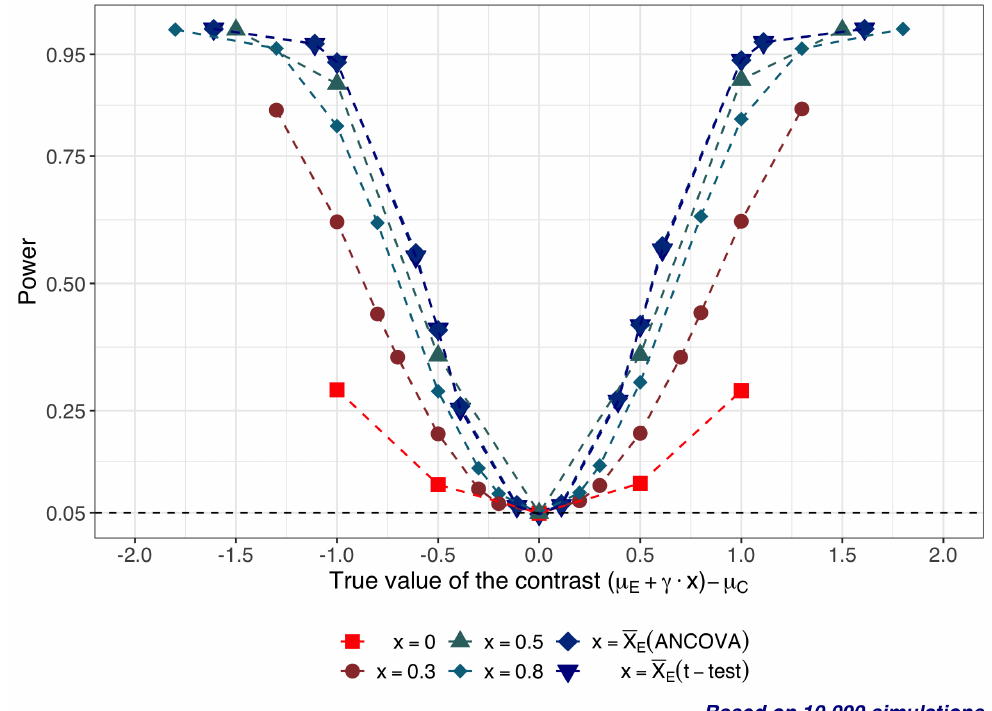
Figure 2. Statistical power for testing H 0 : ∆ x = 0, where ∆ x = ∆ + γ x , for different combinations of ∆ = ( − 1, − 0.5,0,0.5,1 ) , γ = ( − 1, − 0.5,0,0.5,1 ) , and x = ( 0,0.3,0.5,0.62,0.8 ) . It is assumed that n = 50 (25 subjects per arm) and outcomes are generated from model (1) with parameters µ E = ∆ in the range from − 1 to 1; µ C = 0; γ in the range from − 1 to 1; and σ =